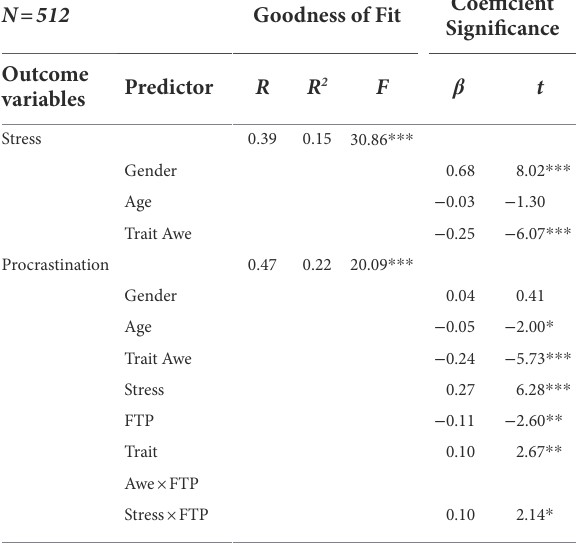
TABLE 3 Analysis of FTP as moderator.